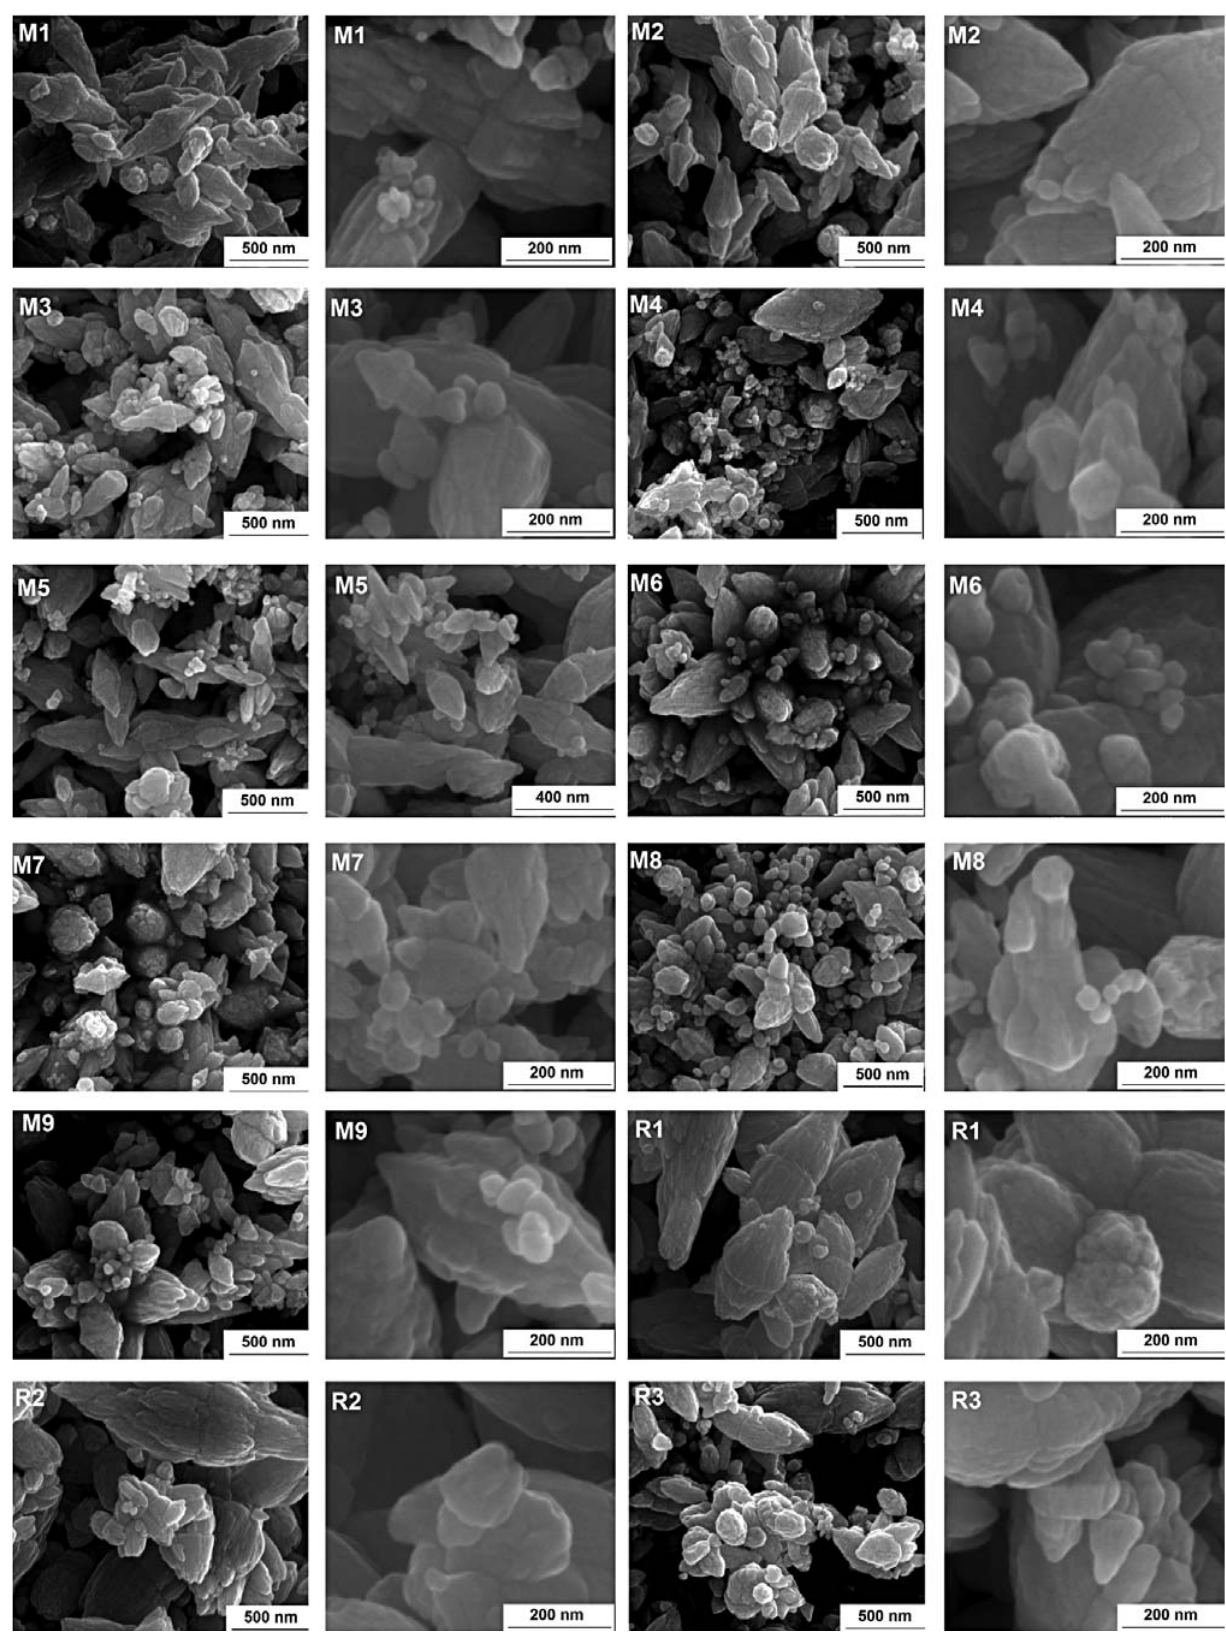
Fig. 1. Photomicrographs of obtained